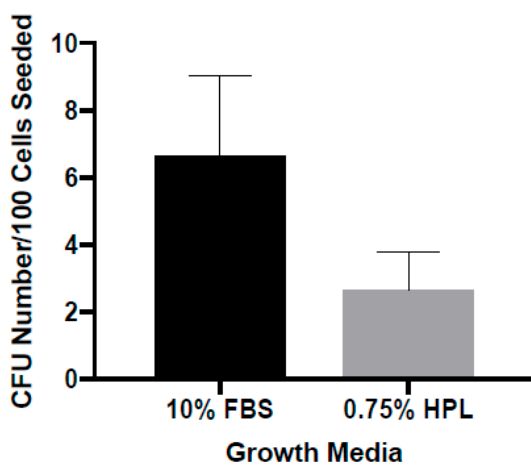
Figure 3. Effect of 0.75% HPL supplementation on the colony-forming unit-fibroblast assay compared to 10% FBS per 10 2 ASC. Stromal media containing 0.75% PL and 10% FBS were tested for impact on ASC colony-forming unit-fibroblast count. Data are reported as the mean ± standard error.; n = 7, one replicate.